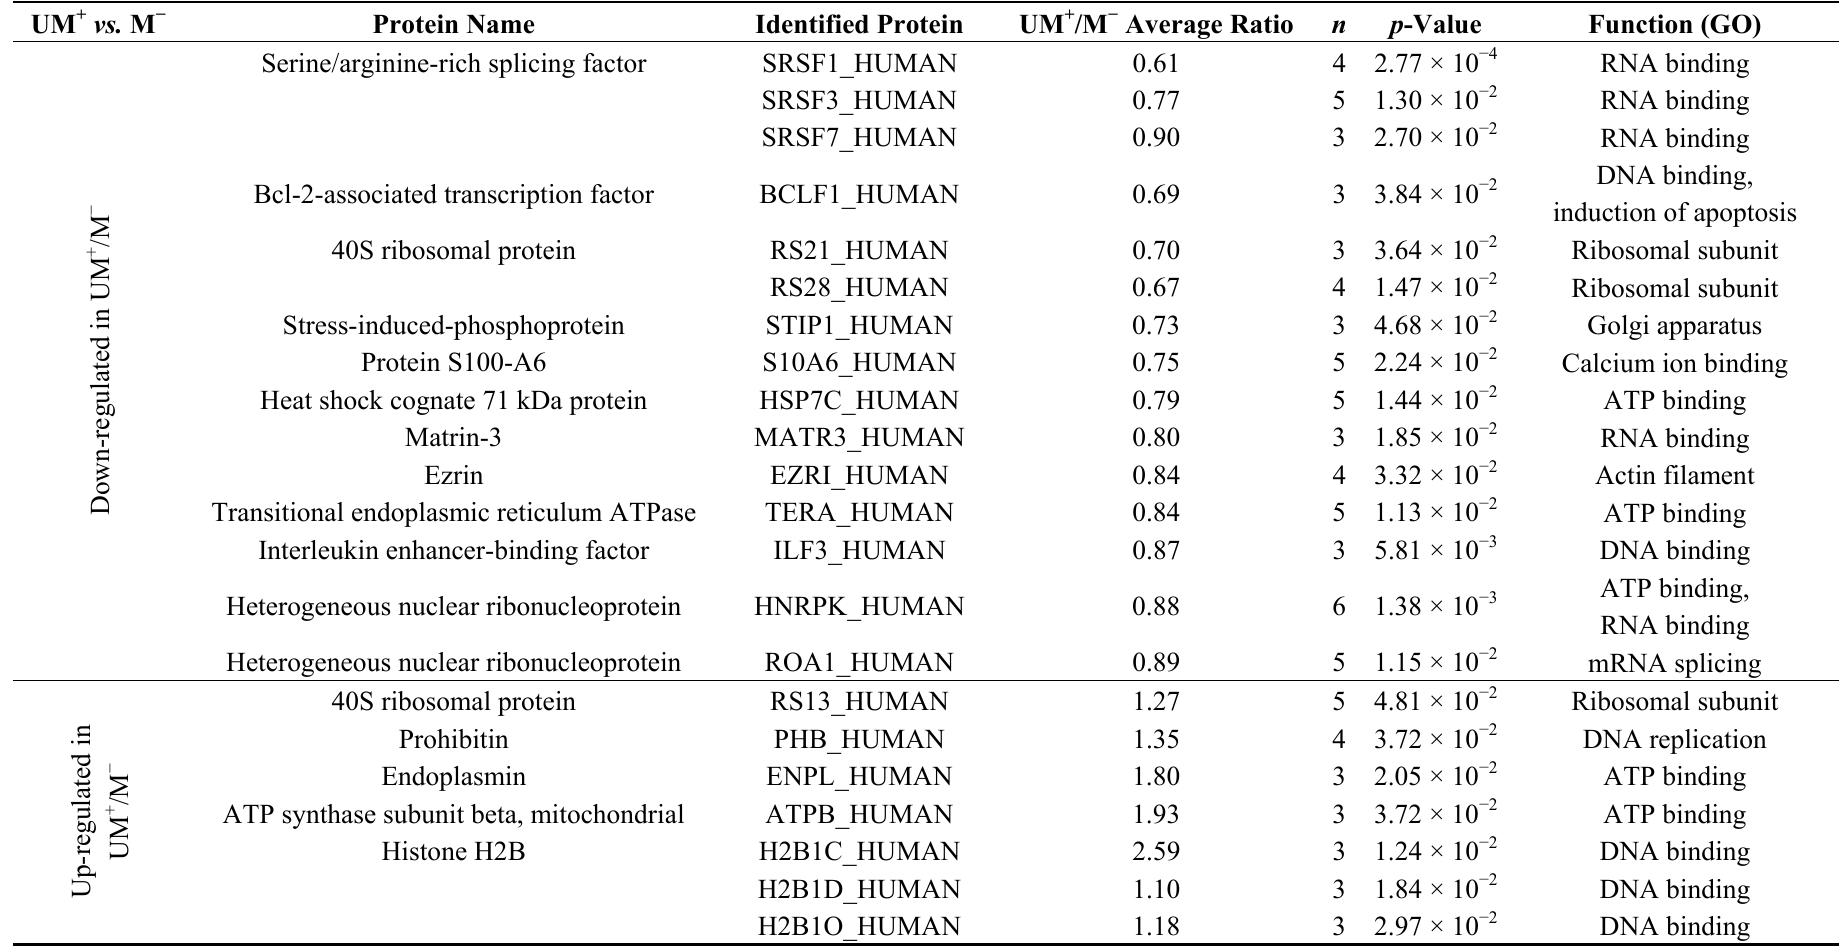
Table 1. Proteins which are differentially expressed between UM + and M − Chronic Lymphocytic Leukemia (CLL) B-cells. The table lists the protein name, Uniprot_ID, average UM + /M − ratio, the number of iTRAQ samples where the protein was identified ( n ), the p -value of the performed t -test and the protein function (derived from UniProt